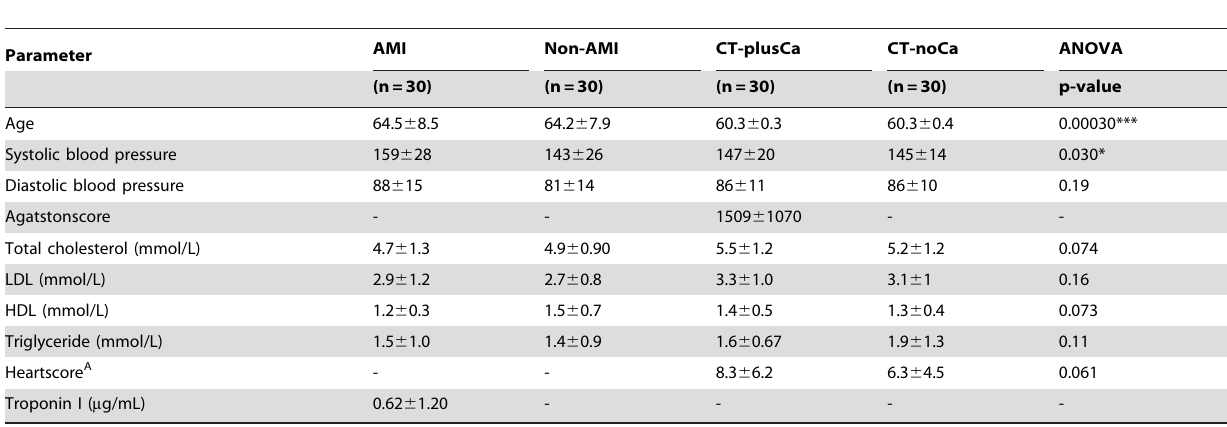
Table 2. Demographical data from the cardiovascular disease